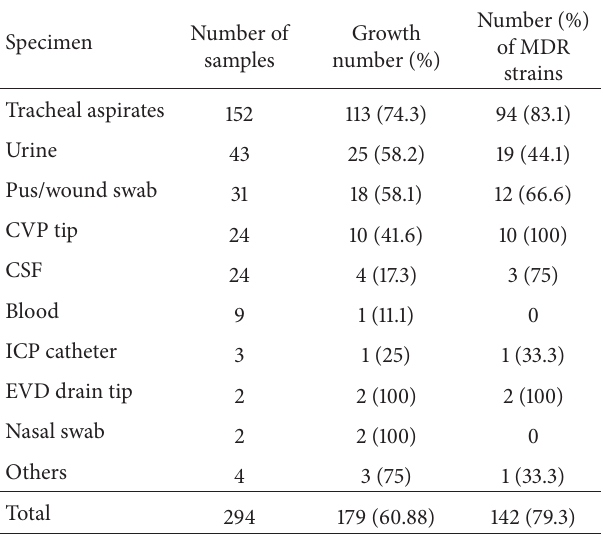
Table 1: Growth pattern and distribution of MDR isolates in differ- ent